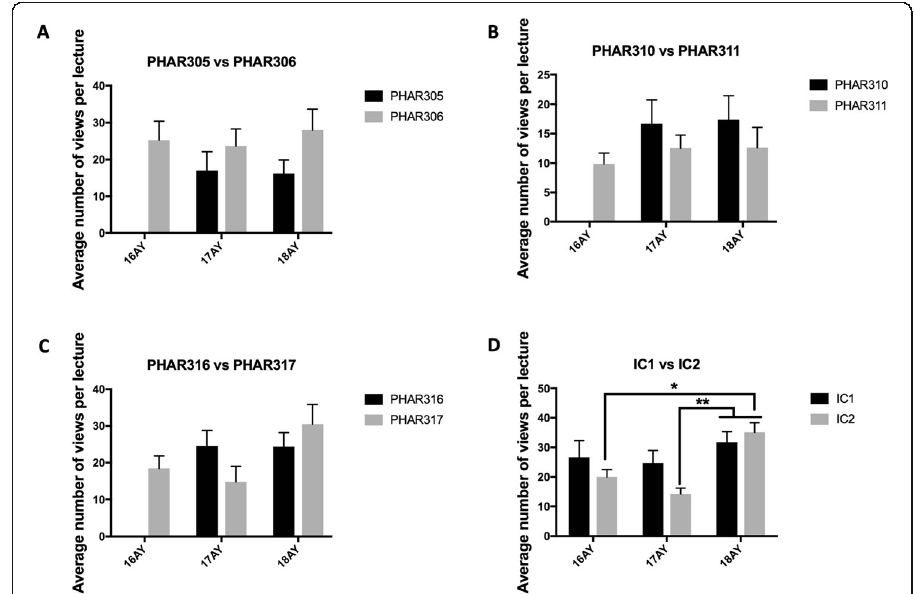
Fig. 2 Comparison of Fall and Spring semester courses delivered in series in Professional Year 2 over three academic years (16AY, 17AY and 18AY). Black bars indicate courses delivered in Fall and grey bars indicate courses delivered in Spring semesters. The bar charts represent the average number of views per lecture